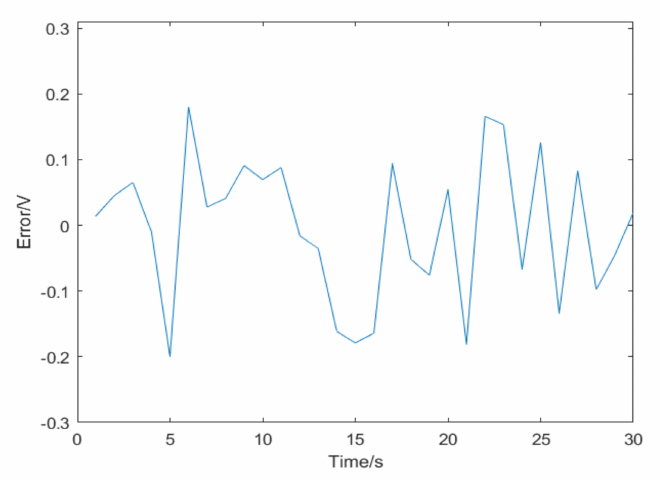
Figure 19. The result errors.